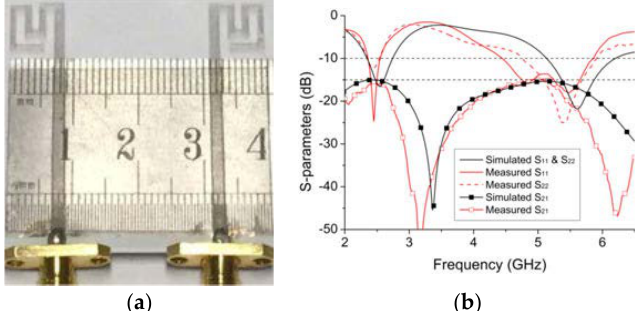
Figure 8. ( a ) Prototyped transparent micro metal mesh conductive film antenna; ( b ) simulated and measured S-parameters of the proposed antenna [30]. (With permission from IEEE).